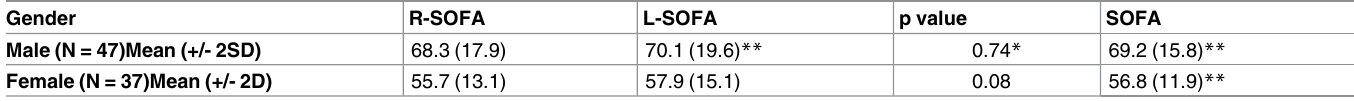
R-SOFA = right superior orbital fissure area; L-SOFA = left superior orbital fissure area distance. * Paired sample t-test with ** variables without normal distribution.